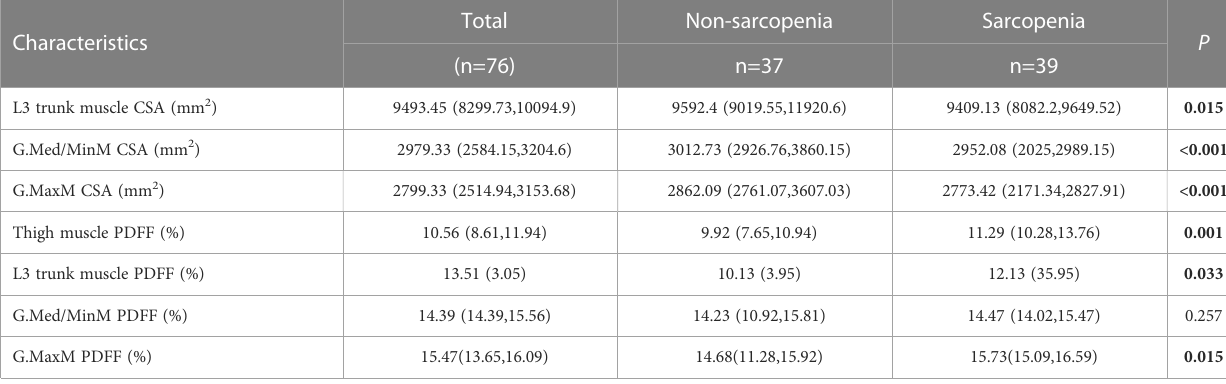
and Figure 2. Except for the PDFF of G.MaxM and G. Med/MinM, the CSA and PDFF of the other muscles correlated with sarcopenia.